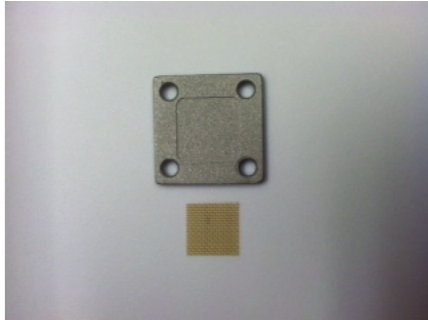
Figure 1: Photograph of a stainless steel plate and the PEEK mem- brane used for preimplantation formation of biofilm used in the Williams sheep model. Courtesy of Dr. D. Williams .